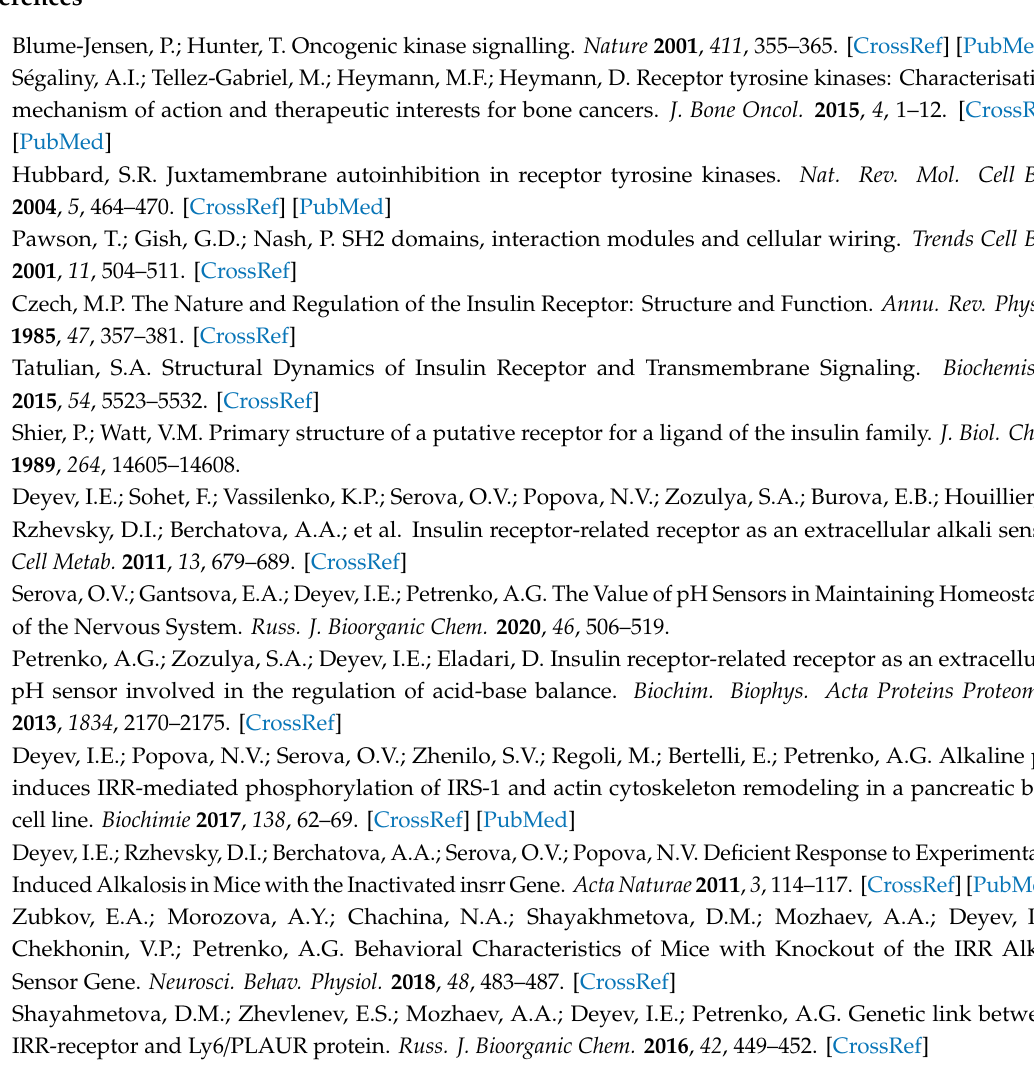
Figure S1: Domain structure of chimeric forms of IRR and mutant forms containing point amino acid substitutions; Figure S2: Results of the Western blotting of control cells (1), hIRR (2), mIRR (3), and purified ectoIRR (4) under reducing conditions using mouse monoclonal antibodies against ectoIRR; Figure S3: Results of the Western blotting of control cells (1), hIRR (2), mIRR (3), and purified ectoIRR (4) under non-reducing conditions using mouse monoclonal antibodies against ectoIRR; Figure S4: Results of ELISA of the antibodies used in this work; Figure S5: Results of the immunoprecipitation of the full-size human IRR and its 10 mutant forms using mouse monoclonal antibodies against ectoIRR; Figure S6: Fluorescence of the HEK293T cells expressing IRR and IRR / IR chimera with L1C domain replacement after the immunocytochemistry using mouse monoclonal antibodies against ectoIRR and secondary anti-mouse Cy3-labeled antibodies; Figure S7: Cross-reactivity test with human IR. Results of the immunoprecipitation of the IRR and IR using mouse monoclonal antibodies against IRR; Figure S8: Cross-reactivity test with human IGF-IR. Results of the immunoprecipitation of the IRR and IGF-IR using mouse monoclonal antibodies against IRR; Figure S9: Cross-reactivity test with mouse IRR; Figure S10: Results of the IRR immunoprecipitation with preliminary incubation of cells in mildly alkaline